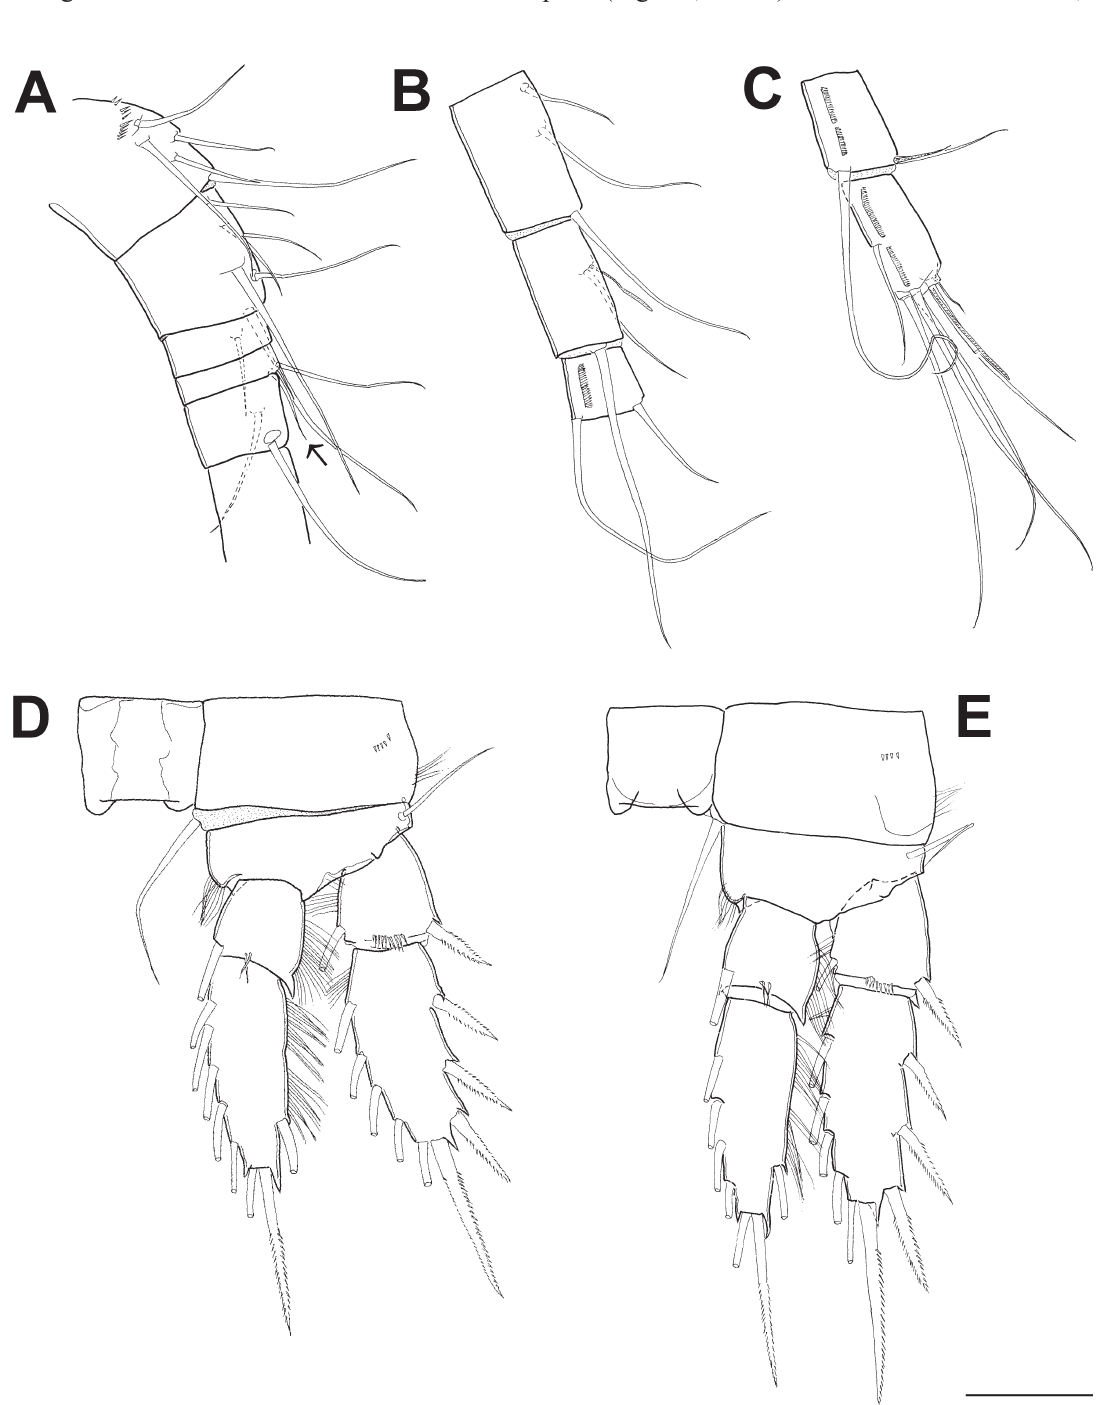
Fig. 6. Cyclops bohater koźmiński, 1933, copepodid iv, ♀. A−C . antennule, ventral. A . segments 1−5 (i−Xvi), arrow points to long anterodistal seta of ancestral segment Xiv. B . segments 6−8 (Xvii− XXiv). C . segments 9−10 (XXv−XXviii). D . Leg 2, caudal. E . Leg 3, caudal. all drawings